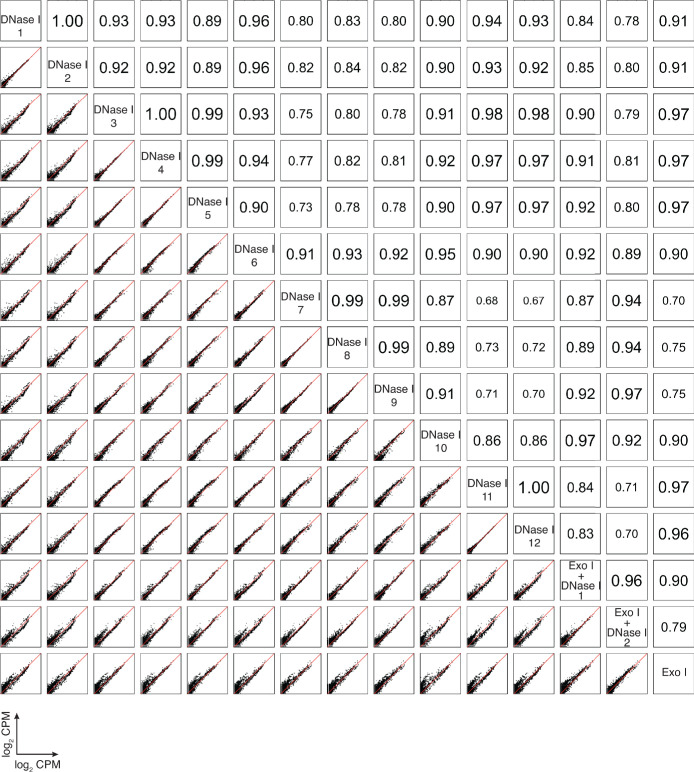
Correlation matrix for individual datasets of plasma RNA after different DNA-removal treatments: DNase I (n = 12) and Exo I ± DNase I (n = 3).For comparisons, CPMs for each gene in a dataset were normalized to the total number of mapped reads in that dataset, log2 transformed, and plotted. Pearson correlation coefficients are shown on the upper triangle. Numbers on the x and y axes of scatter plots are log2 transformed CPMs.